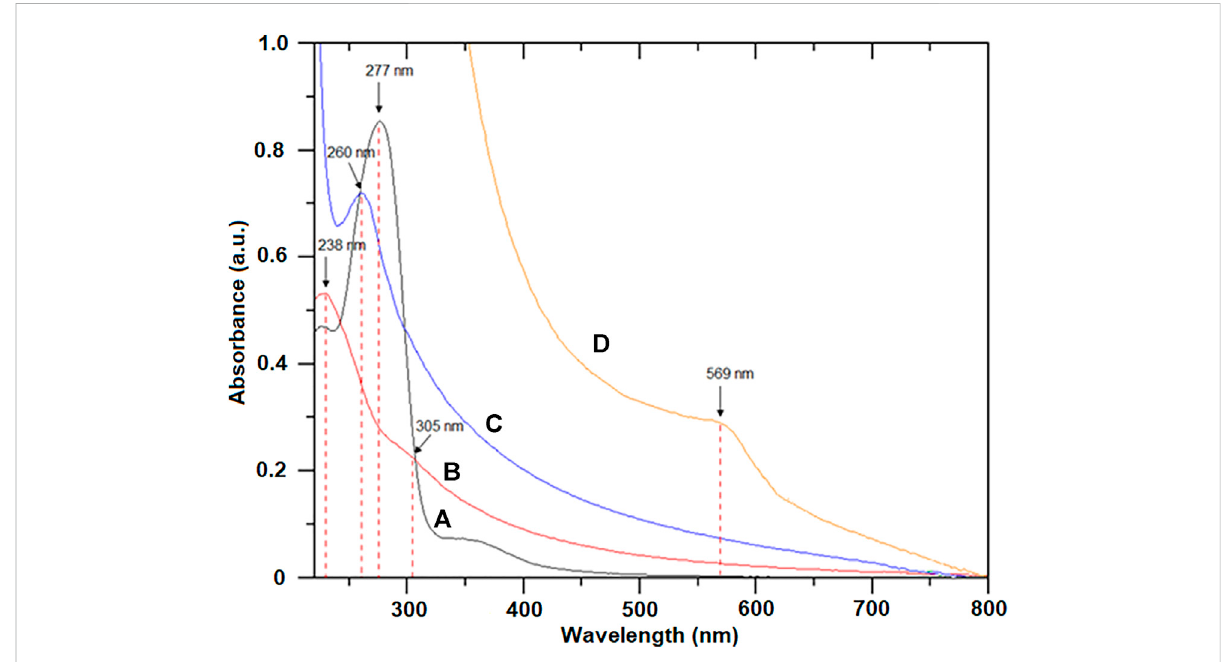
FIGURE 1 UV-visible spectra of (A) honey, (B) GO, (C) RGO, and (D) H/Cu/RGO